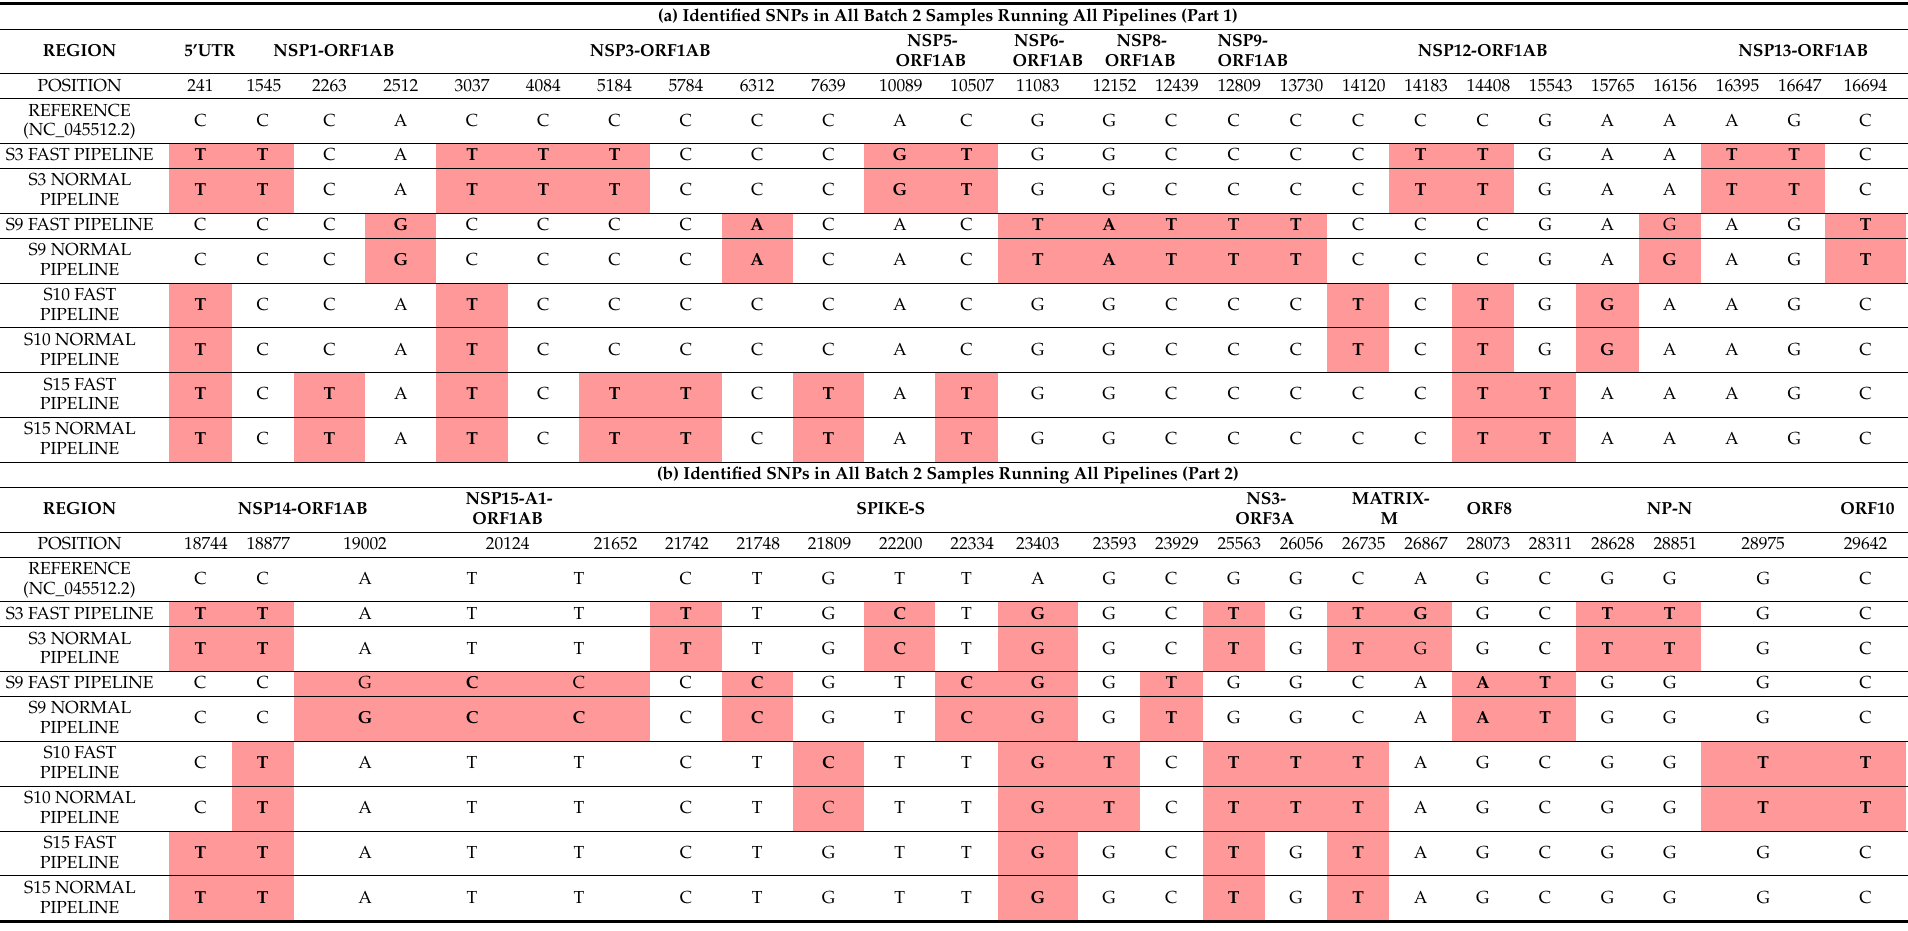
Table 9. (a) Identified SNPs in All Batch 2 Samples Running All Pipelines (Part 1). (b) Identified SNPs in All Batch 2 Samples Running All Pipelines (Part 2). (a) Identified SNPs in All Batch 2 Samples Running All Pipelines (Part